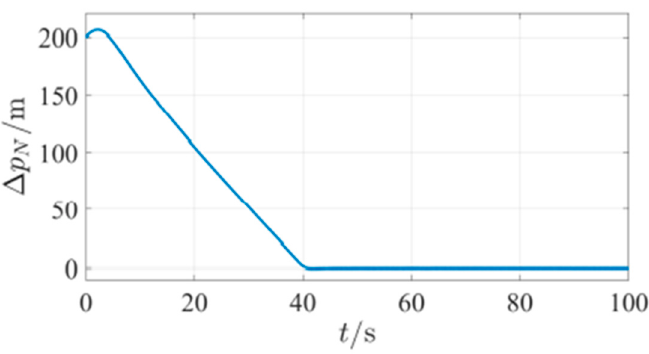
Figure 37. The relative displacement between north and south direction of the mobile platform during landing process.